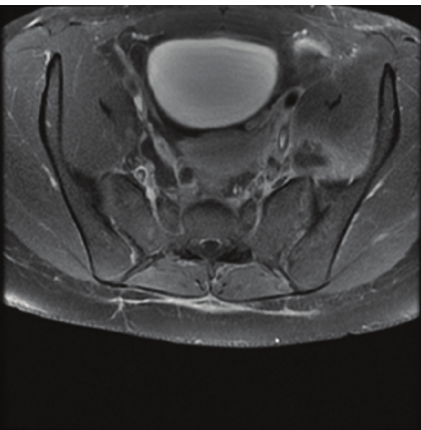
Figure 1: MRI of SI joints demonstrating an area of focal enhance- ment in the left sacroiliac joint and a septated abscess in the left iliopsoas